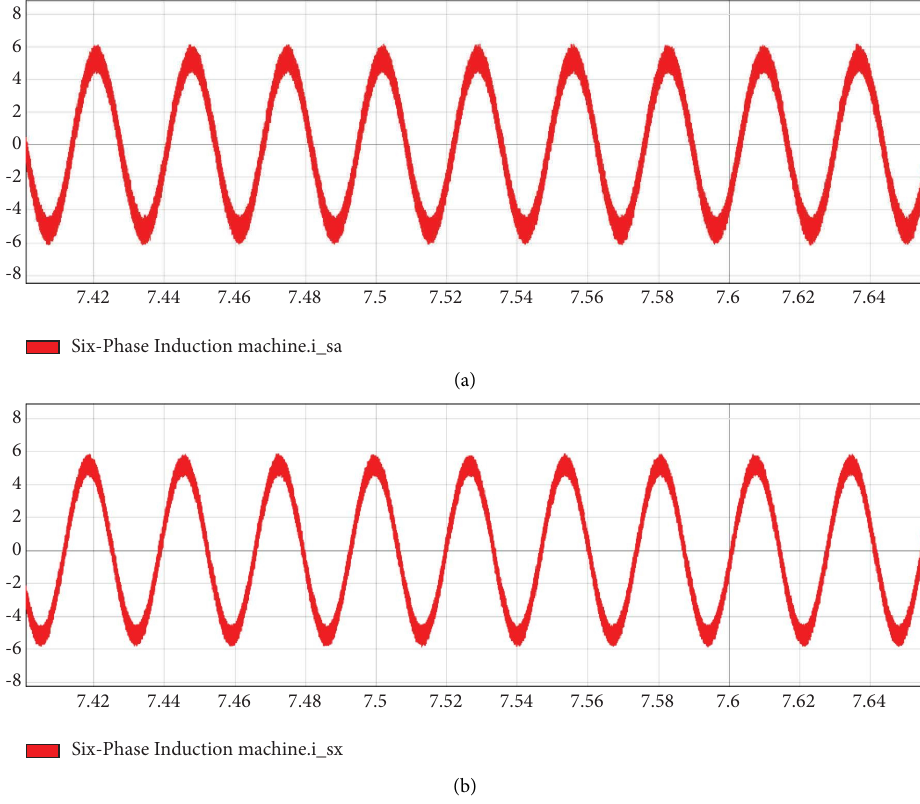
Figure 14: Real-time test results during steady-state operation: (a) winding current of phase a ; (b) winding current of phase x .